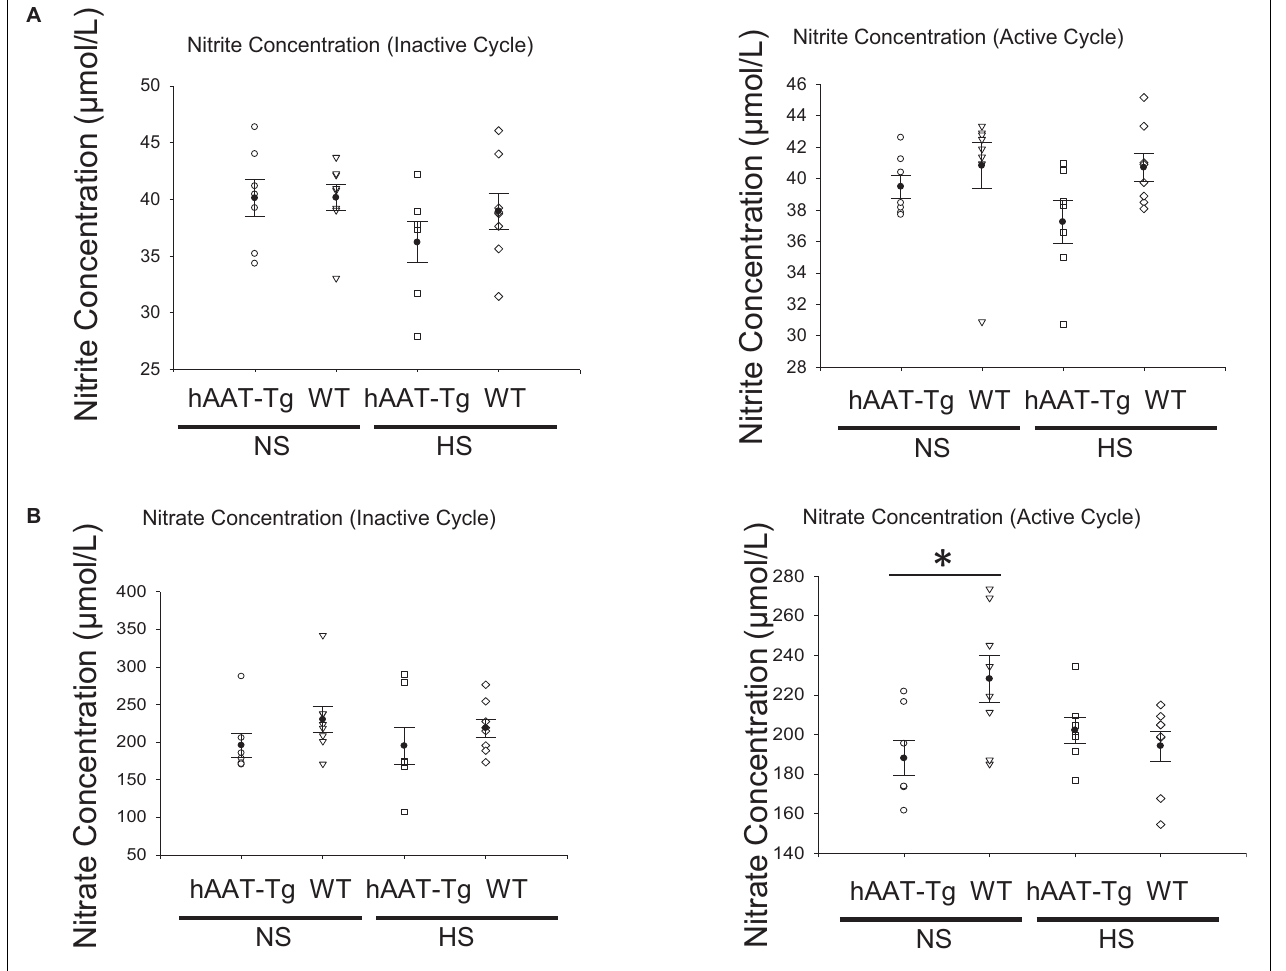
FIGURE 8 | Blood nitrite and nitrate concentration analysis. (A) Nitrite concentrations in the blood of female and male hAAT-Tg mice and C57B/6 wild-type mice in the inactive cycle (AM) or active cycle (PM). (B) Nitrate concentrations in the blood of female and male hAAT-Tg mice and C57B/6 wild-type mice in the inactive